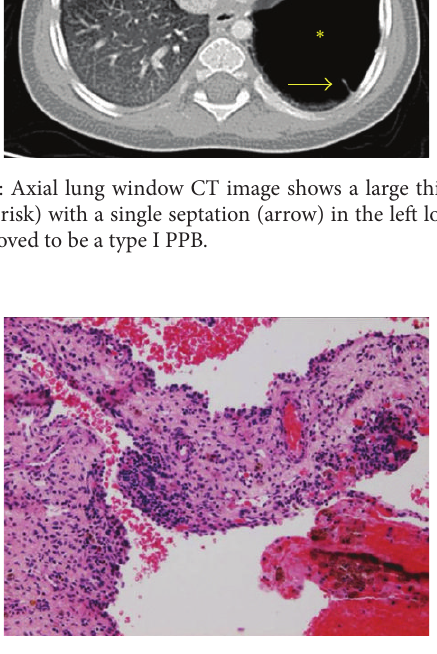
Figure 2: Surgical resection specimen demonstrates focal mes- enchymal hypercellularity consistent with pleuropulmonary blas- toma type 1 (H&E; original magnification × 100).